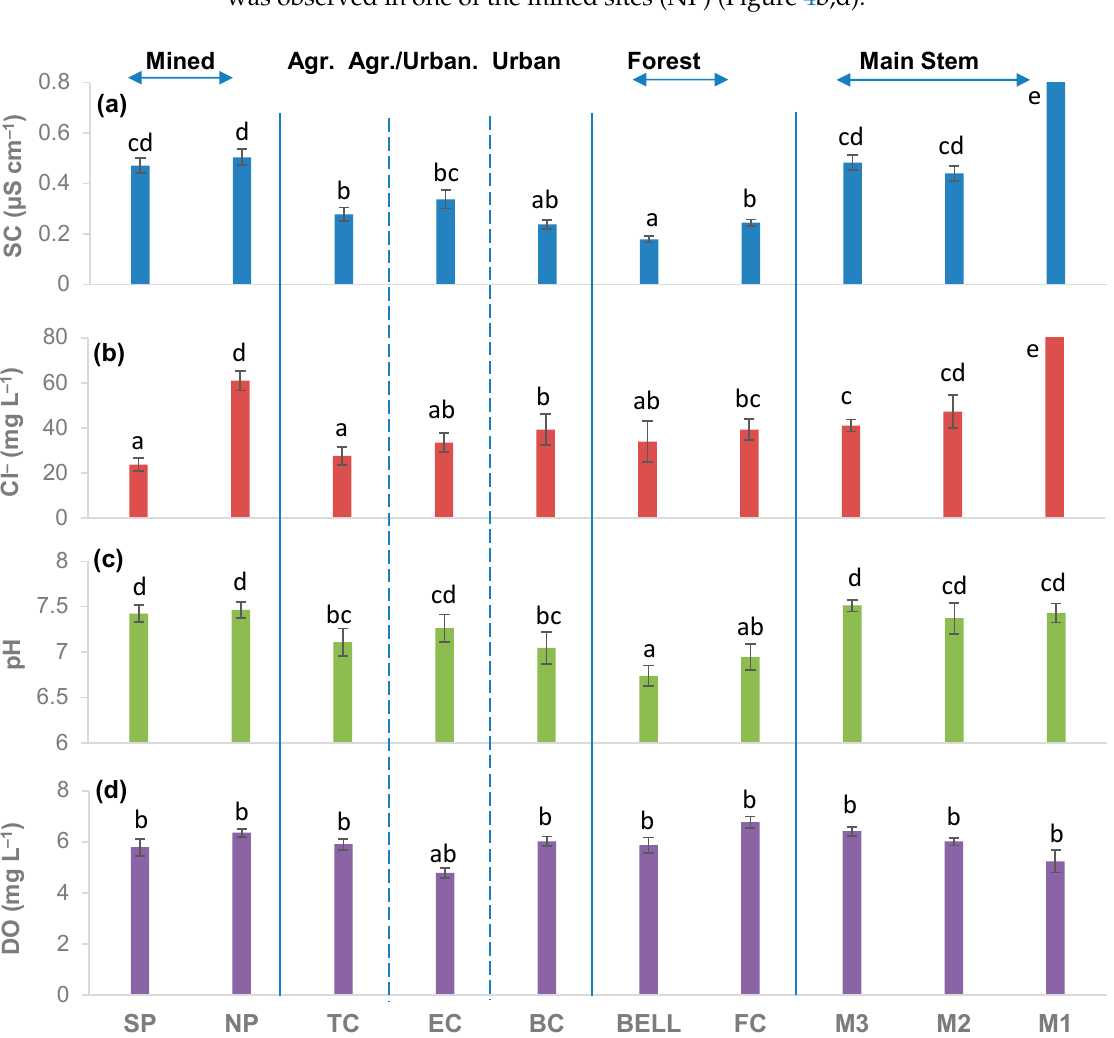
Figure 4. Changes in ( a ) specific conductance (SC), ( b ) chloride (Cl − ), ( c ) pH, and ( d ) dissolved oxygen (DO) across a land-use gradient of the Alafia River. Stations marked by different letters (a–e) are significantly different at p < 0.05. NP: North Prong; SP: South Prong; TC: Turkey Creek; EC: English Creek; BC: Buckhorn Creek; FC: Fishhawk Creek. Note that extremely high values of SC and Cl − at site M1 (4.48 ± 1.58 µ S cm − 1 and 800 ± 192 mg L − 1 ) are not shown due to limited y -axis scales. Table 3. Correlation coefficients between land-use and nitrogen and phosphorus forms in the streamwaters of the Alafia River Watershed over 23 sampling events (April–October 2009).